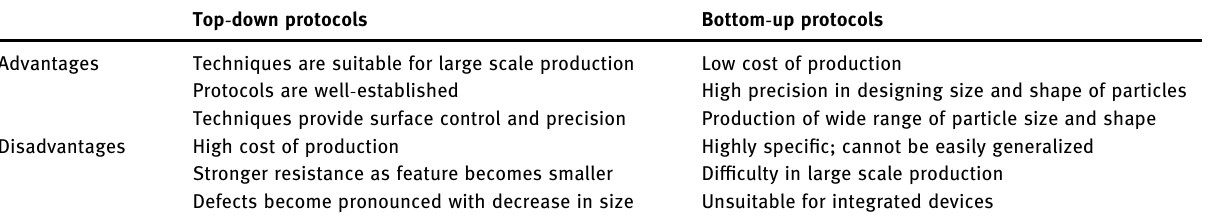
Table 3: Comparison of top - down and bottom - up protocols Top - down protocols Bottom - up